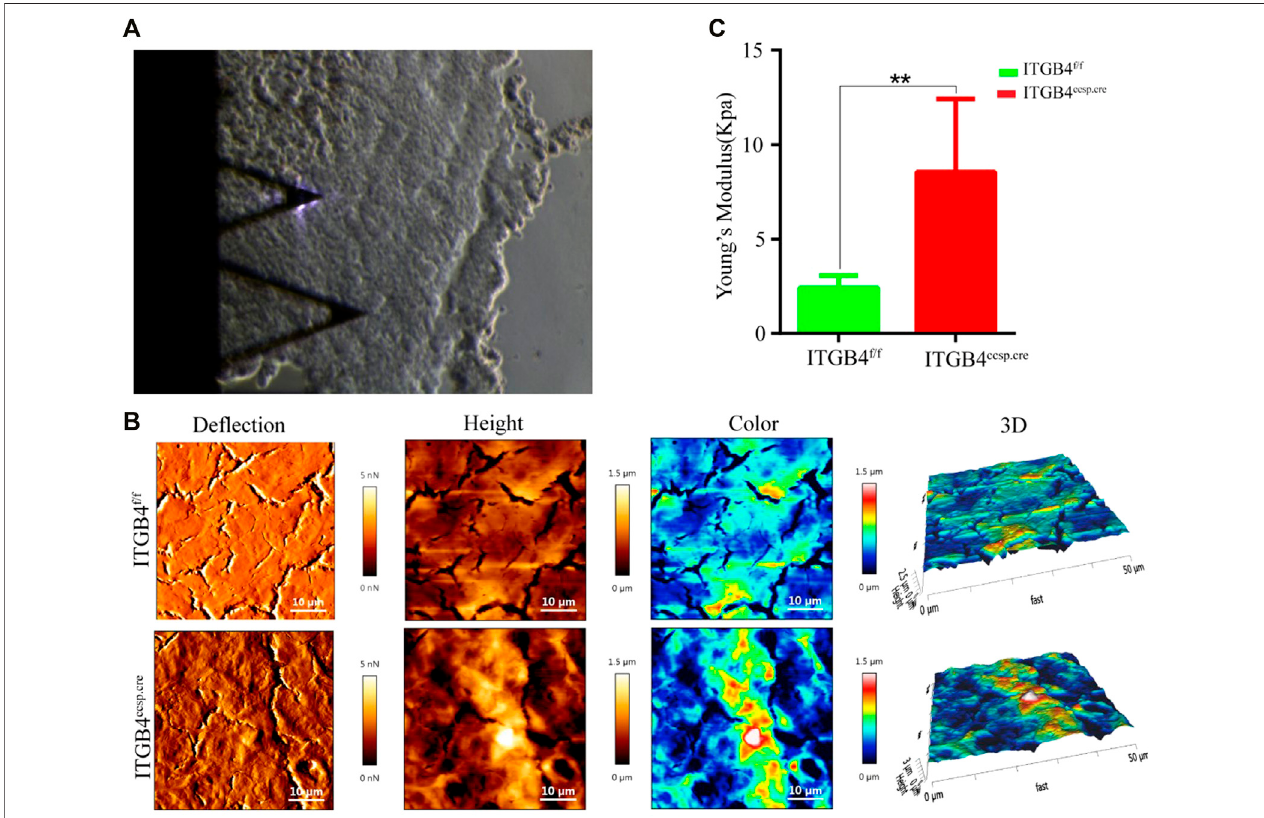
FIGURE 2 | The morphology and mechanical properties of ITGB4 f/f and ITGB4 ccsp.cre mice was detected by using AFM. (A) Optical microscopy image of the lung section withtheAFM tipincontact. (B) Representativelungtissue surfaceimages inAFM contactmode (de fl ection image; heightimage; colorimage and3D image). (C) lung tissue stiffness or Young ’ s modulus were calculated by fi tting the force-indentation curve to Hertz mode. ( n = 3 independent experiments, ** p < 0.01). Data are presented as mean ± SD.